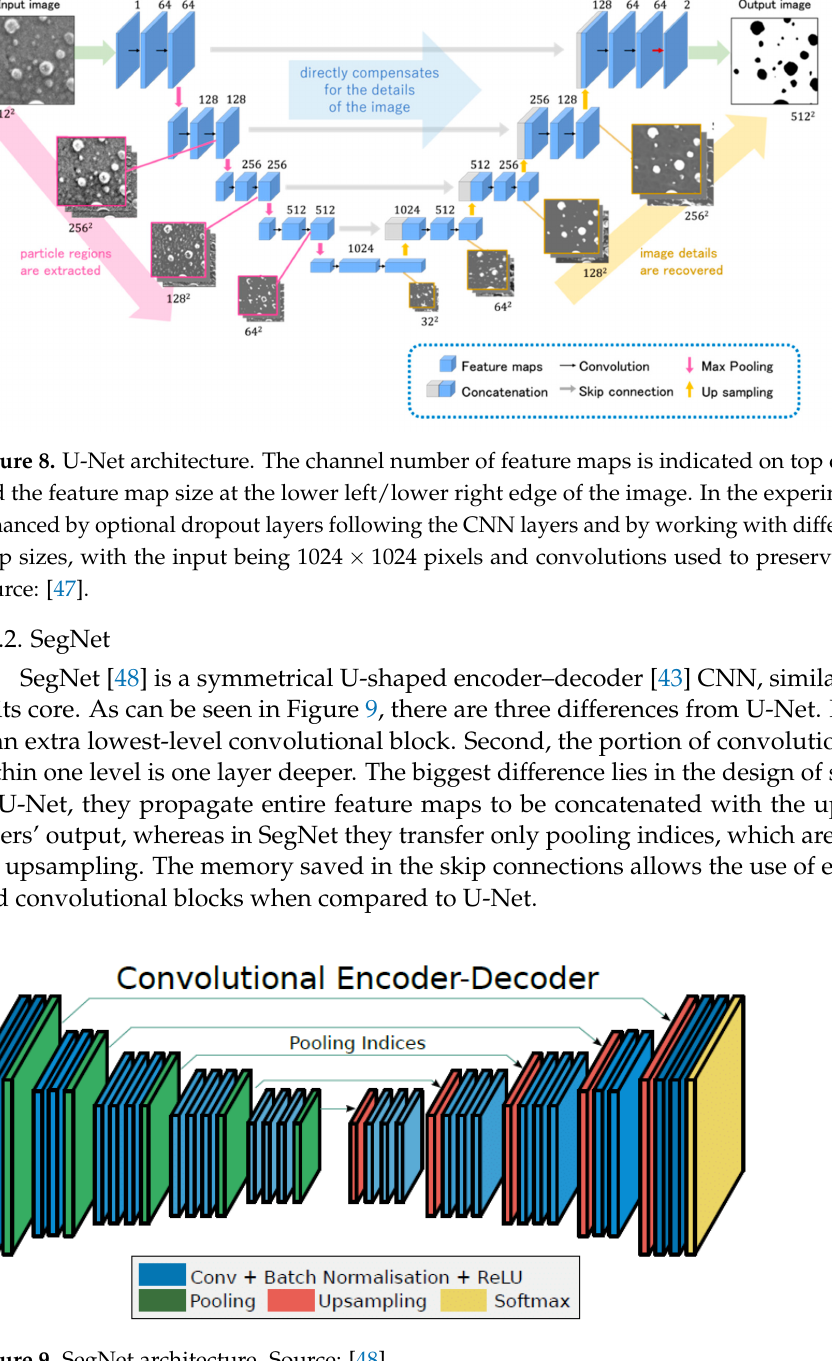
Figure 9. SegNet architecture. Source: